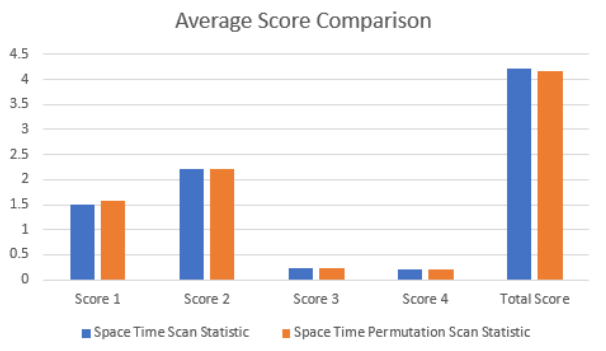
Figure A5. Average score comparison.